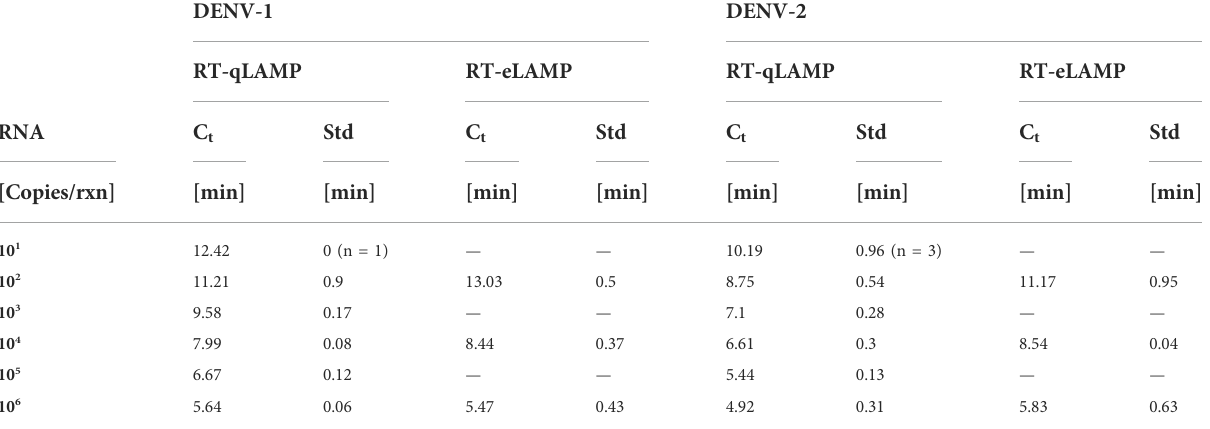
TABLE 2 Performance of the DENV RT-qLAMP (n = 4) and RT-eLAMP (n = 3) assays showing cross-threshold C t value and associated standard deviation across repeats. For 10 1 copies/reaction, we indicate the number of positive repeats. DENV-1 DENV-2 RT-qLAMP RT-eLAMP RT-qLAMP RT-eLAMP RNA C t Std C t Std C t Std C t